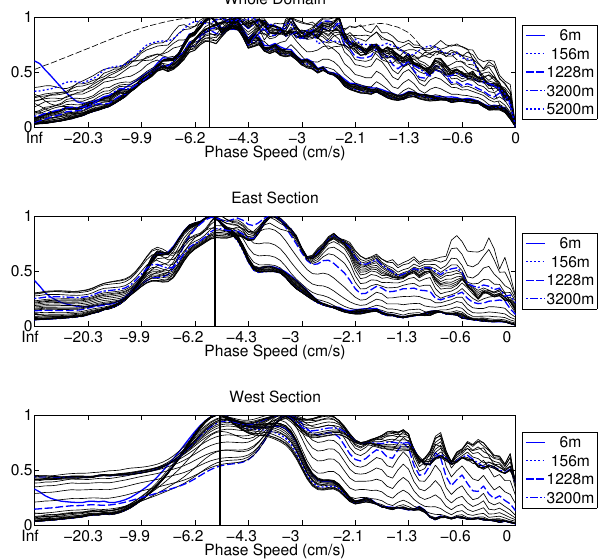
Fig. 2. The normalized amplitude of the Radon transform with phase speed for (a) the whole domain, (b) the East Atlantic and (c) the West Atlantic. Black vertical lines indicate the dominant phase speed.